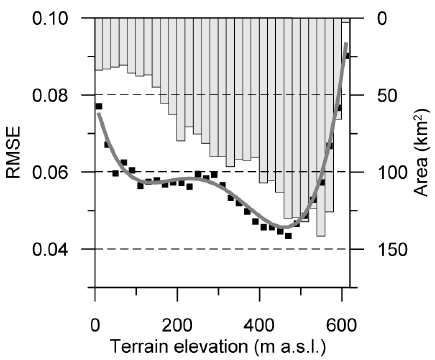
Fig. 9. Error range of the FAM expressed as 4th-order polynomial function of terrain elevation (grey line). The function is fitted to the profile of RMSE between observed and modelled albedo val- ues (black symbols). Given data pairs refer to the period March– October of the years 2001–2008. The bar chart shows the area- altitude distribution of Vestfonna ice